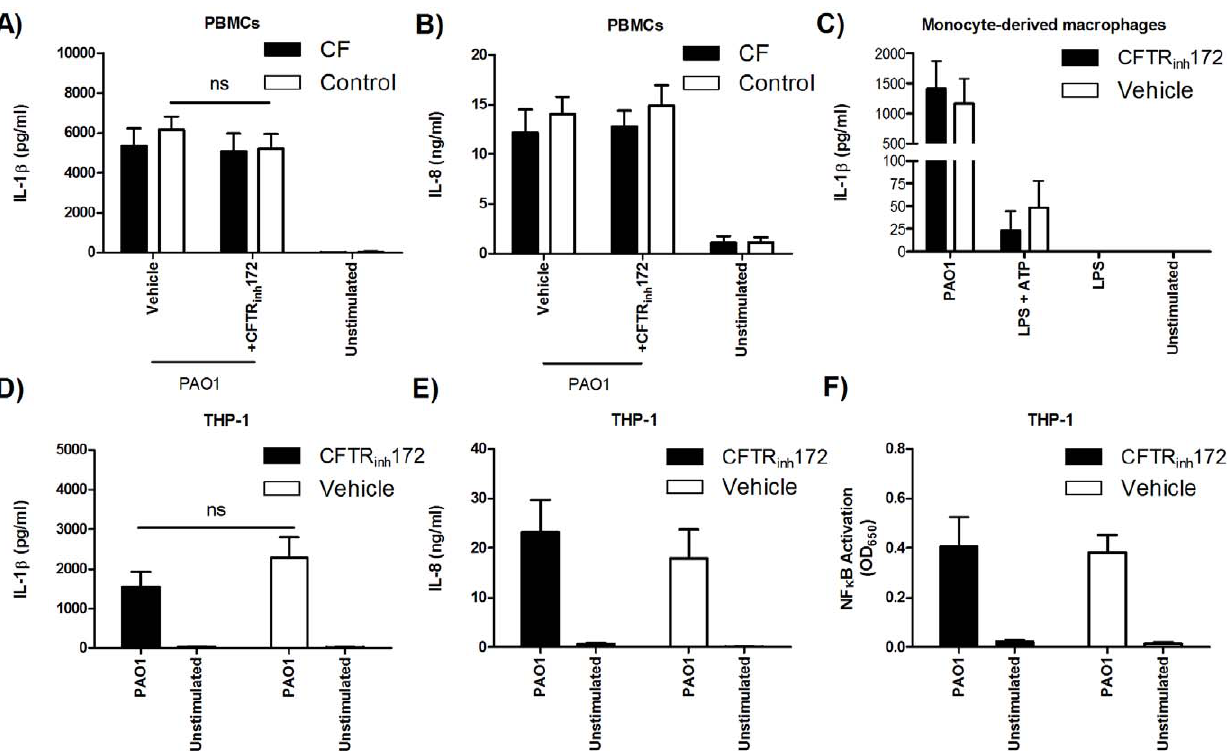
Figure 8. Disruption of CFTR activity does not increase IL-1 b production in PBMCs or macrophages. PBMCs from CF patients (n=15) and controls (n=13) were treated with CFTR inh 172 (10 m M) for 18 hours prior to stimulation with live PAO1 (MOI=1). (A) IL-1 b and (B) IL-8 production was measured at 24 hours. (C) Monocytes from controls (n=3) were differentiated into macrophages. Macrophages were treated with CFTR inh 172, stimulated as per monocytes, and measured for IL-1 b production at 24 hours. THP-1 reporter cells were treated with CFTR inh 172 24 hours prior to stimulation with PAO1 and measured for (D) IL-1 b secretion, (E) IL-8, and (F) NF- k B/AP-1 activity at 24 hours (n=4).